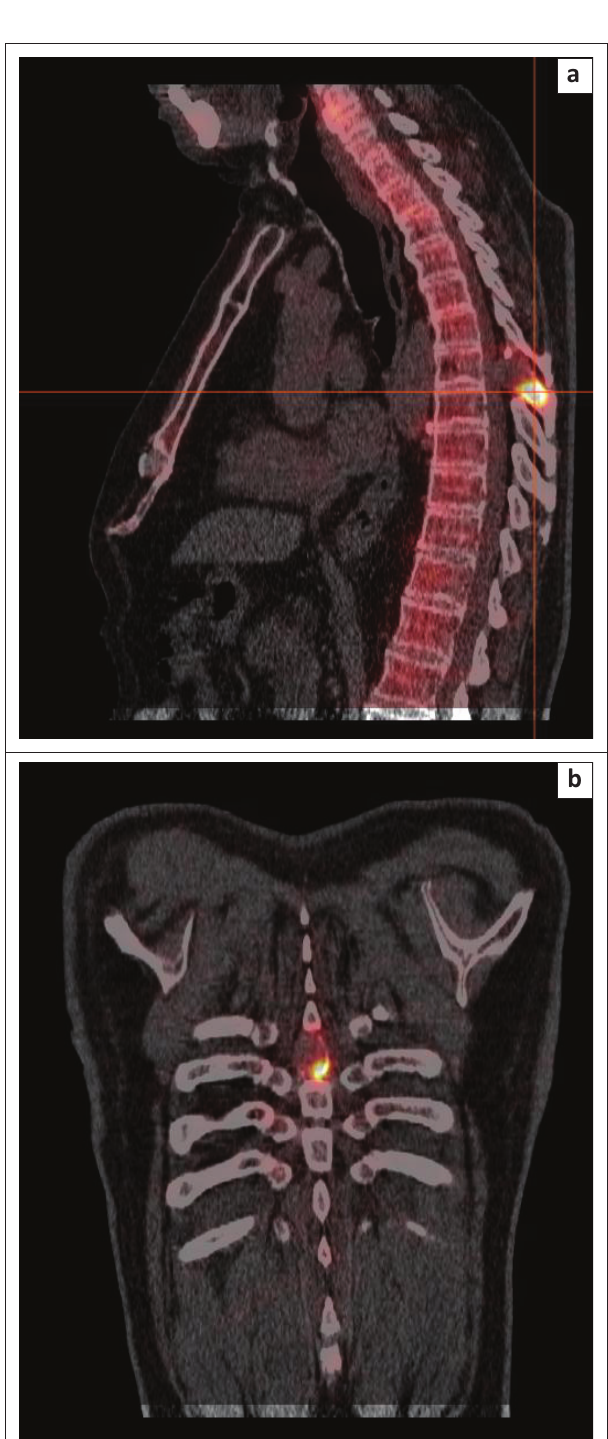
FIGURE 2: A 79-year-old male known with carcinoma of the prostate and a prostate specific antigen (PSA) doubling time of less than 6 months: Sagittal (a) and Coronal (b) fused SPECT-CT images showing an area of intense 99m Tc-MDP uptake adjacent to an expansile lytic lesion localised to the spinous process and lamina of